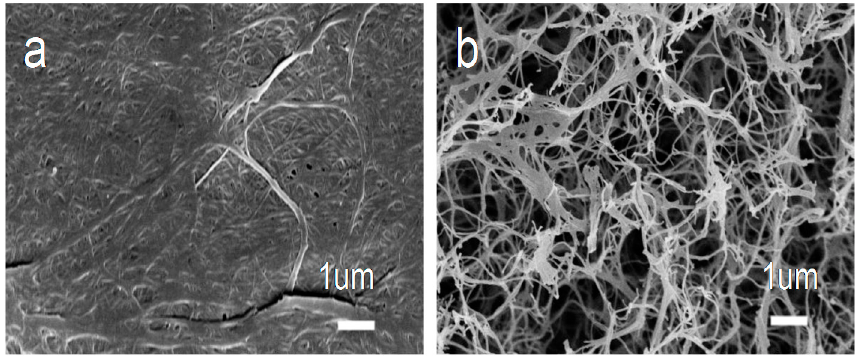
Figure 2. SEM image of ( a ) the surface and ( b ) the inner of N/P/S-PBC-3.